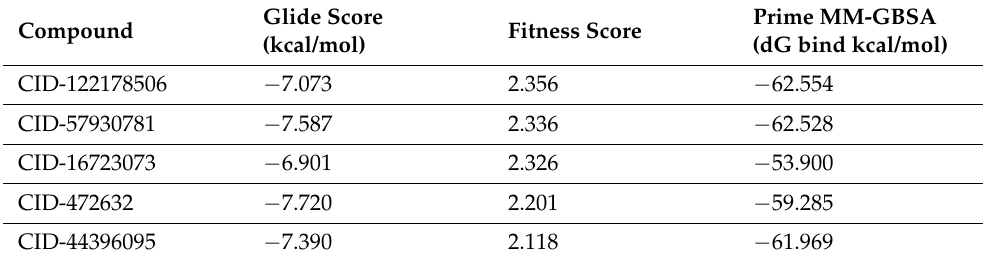
Table 1. The results of the lead compounds from the Glide XP docking and Prime MM-GBSA.